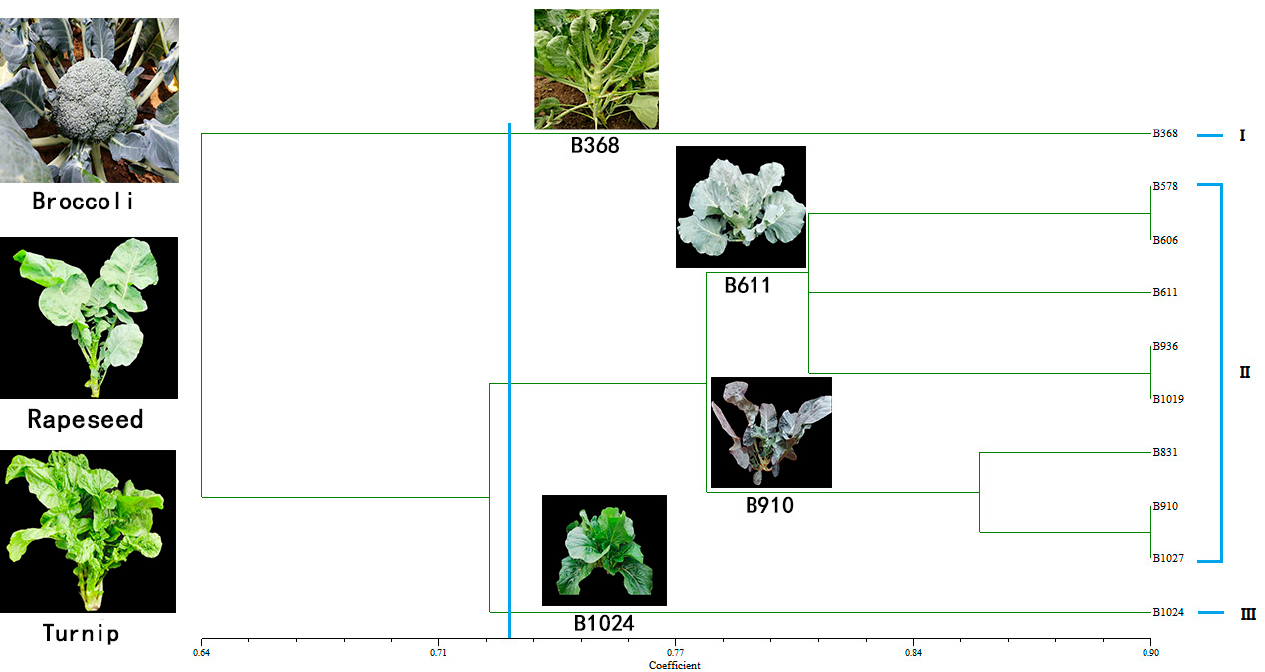
Figure 3. Genetic diversity of 10 broccoli accessions. Dendrogram constructed from cluster analysis by UPGMA. The 10 broccoli accessions were divided into three major groups (I, II, and III).